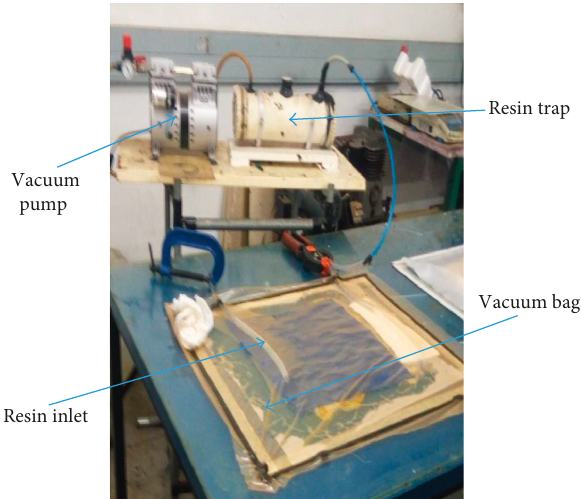
Figure 1: The vacuum infusion